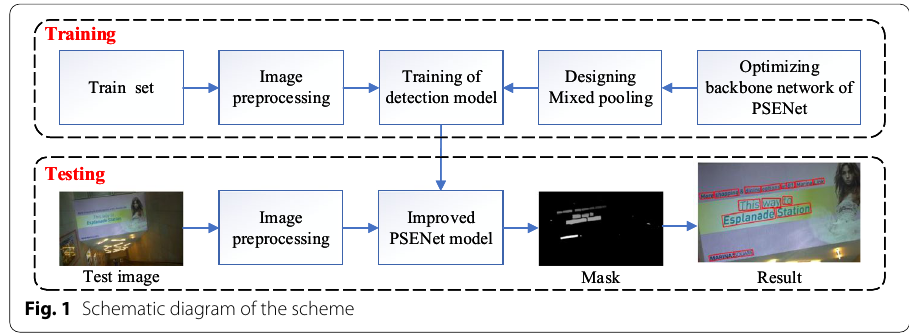
Fig. 1 Schematic diagram of the scheme